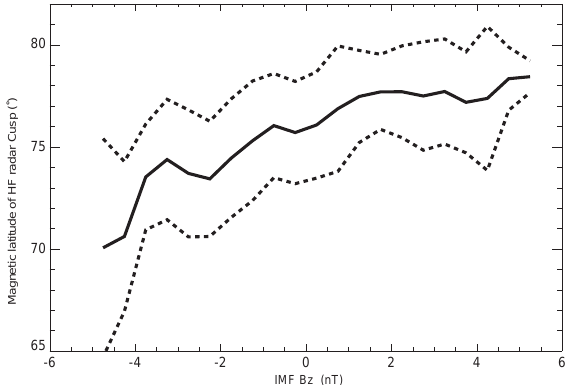
Fig. 2. Scatterplot of the locations of the HF radar cusp, such as those illustrated in Fig. 1, for prevailing IMF conditions with a southward (negative) IMF B Z between − 1.5 and − 1.0nT.